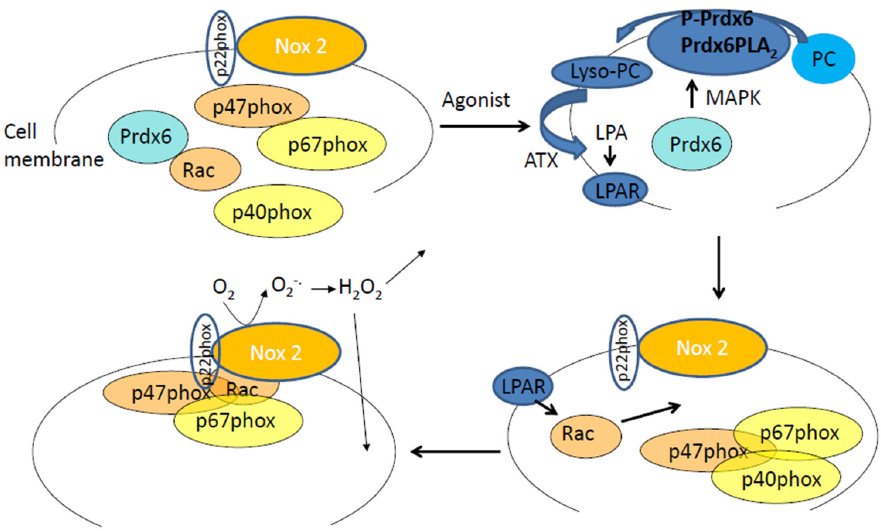
Figure 1. The Prdx6–PLA 2 activity and the production of reactive oxygen species (ROS) by endothelial cells in response to an agonist. In the cytosol are Prdx6 and cytosolic subunits of NADPH 2 oxidase (p40phox, p67phox, p47phox, and Rac). Upon phosphorylation (in response to an agonist, Angiotensin II, or LPS) Prdx6 translocates to the plasma membrane. P-Prdx6 has phosphospholipase A 2 activity via which it hydrolyses membrane phosphatidylcholine (PC) to lysophosphatidylcholine (lyso-PC). Lyso-PC is catalyzed to lysophosphatidic acid (LPA) by the enzyme autotaxin (ATX). LPA binds to its receptor on the cell membrane, and the resulting signaling cascade leads to Rac phosphorylation that in turn enables assembly of the cytosolic components of NADPH oxidase 2 with the membrane bound components (gp91phox or Nox2 and p22phox). The assembled enzyme reduces molecular oxygen to superoxide which then dismutates to hydrogen peroxide. H 2 O 2 can participate in extracellular and intracellular signaling cascades.